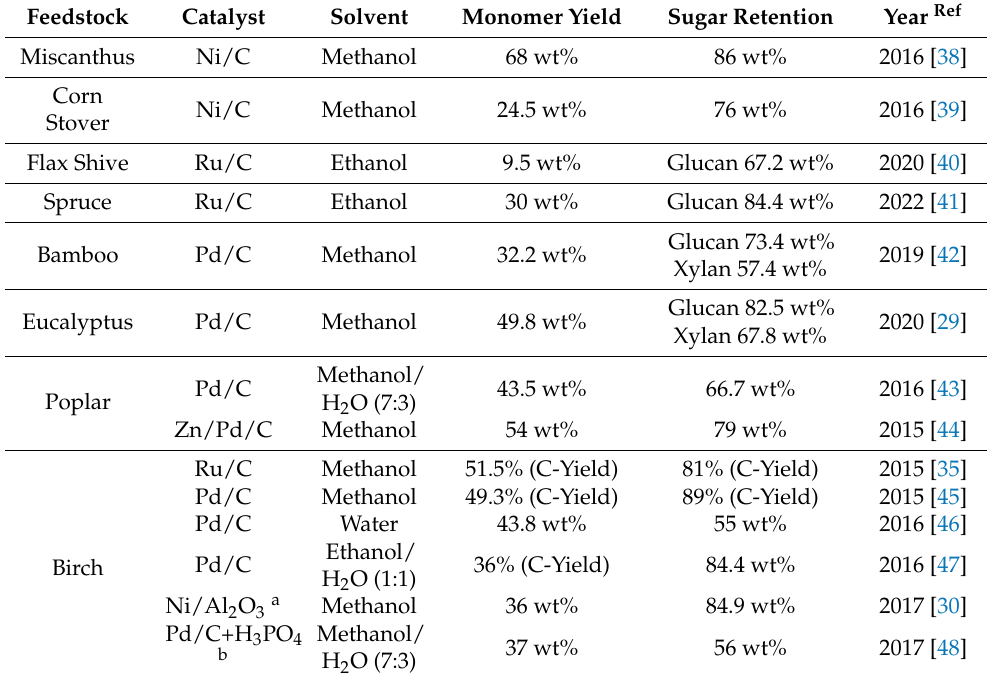
Table 2. Reductive catalytic fractionation of biomass